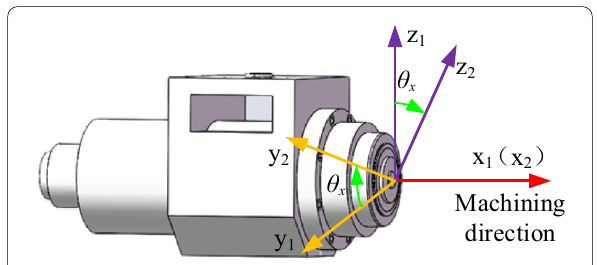
Figure 5 Rotation angle of the